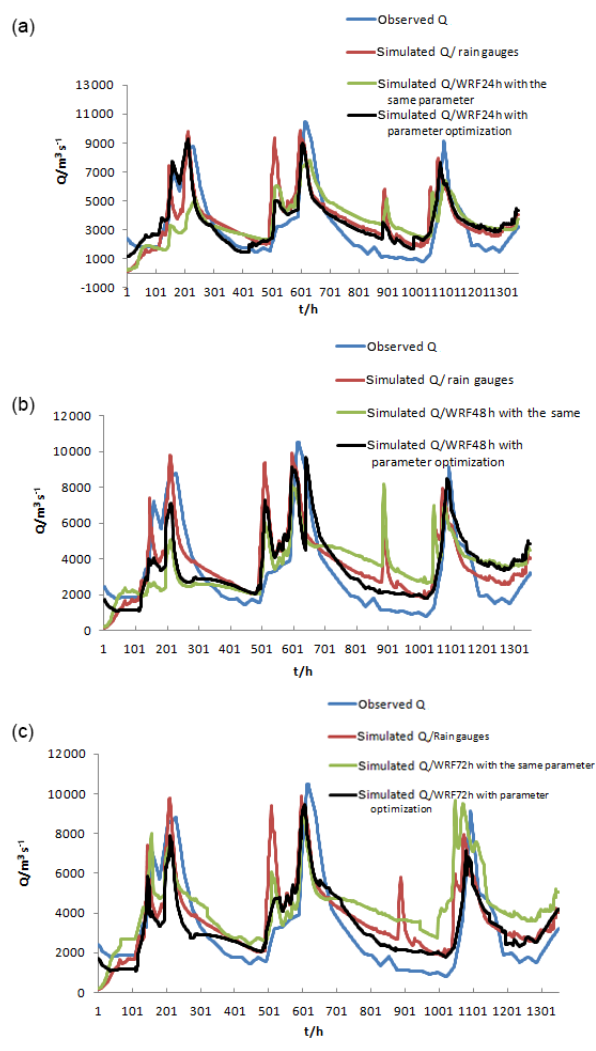
Figure 10. Coupled flood simulation results with the re-optimized model parameters (2012). (a) is the simulated result with 24h lead time, (b) is the simulated result with 48h lead time, and (c) is the simulated result with 48h lead